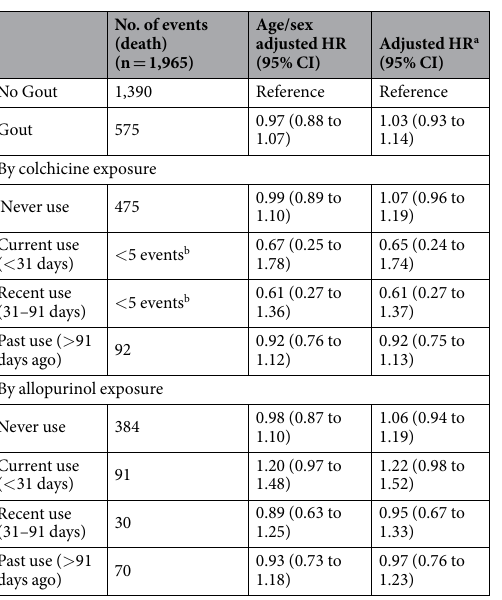
Table 4. Risk of infection-related mortality due to pneumonia, in patients with gout compared to matched controls, stratified by use of colchicine and allopurinol. Abbreviations: HR: indicates hazards ratio; CI, confidence interval; PY, person years. (a) Adjusted for age, sex, body mass index, smoking status, alcohol use, the most recently recorded estimated glomerular filtration rate in the past year, a history of dementia, dysphagia, stroke, epilepsy, ischaemic heart disease, sepsis and the use of bronchodilators, inhalation corticosteroids, systemic corticosteroids, non-insulin anti-diabetic drugs and insulin within 6 months before, the use of influenza vaccinations 1 year before and the use of pneumococcal vaccinations 5 years before. (b) According to Independent Scientific Advisory Committee (ISAC) guidance on the content of protocols for research using CPRD data no cell containing < 5 events are